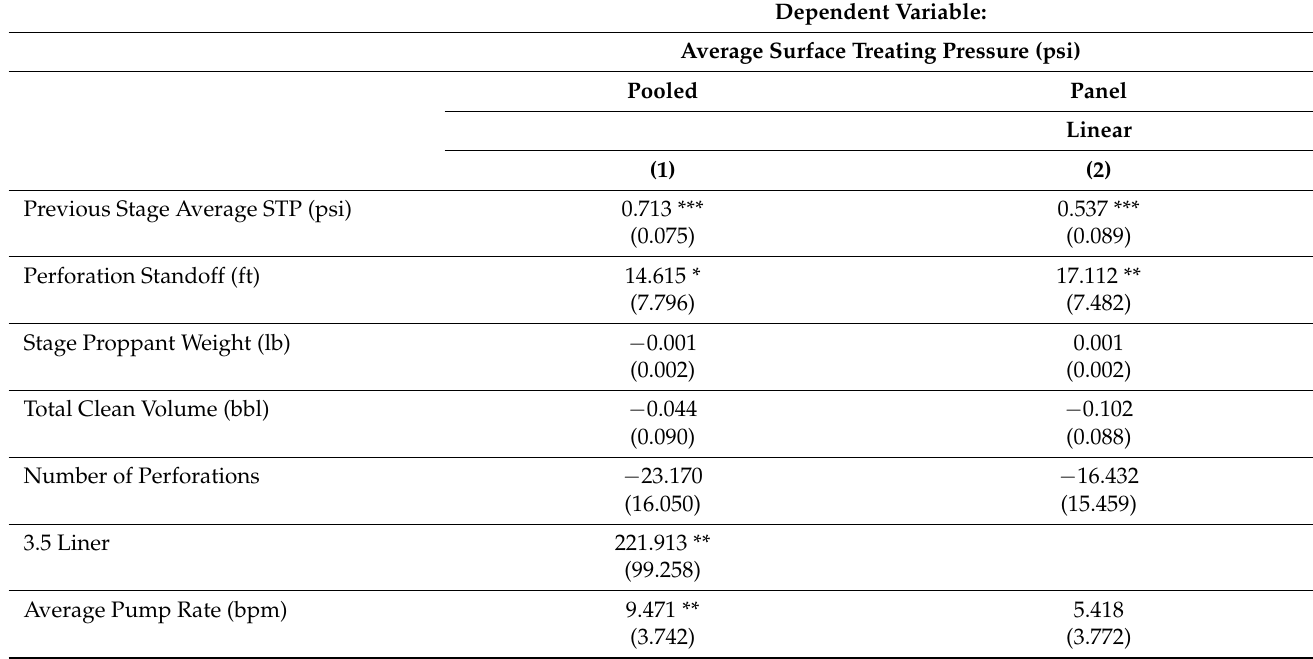
Table 4. Model summaries from panel linear (FE) models and pooled models from Kroschel, Rabiei, and Rasouli (2022) using the stargazer package from R